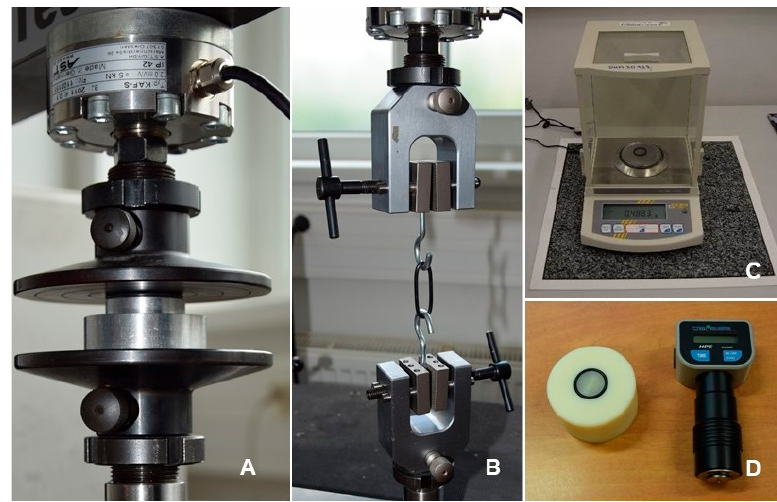
Figure 1. Measurement of the mechanical properties: ( A ): permanent deformation CS , ( B ): tensile strength TS and elongation Eb , ( C ): mass, ( D ): hardness Shore A SHA.